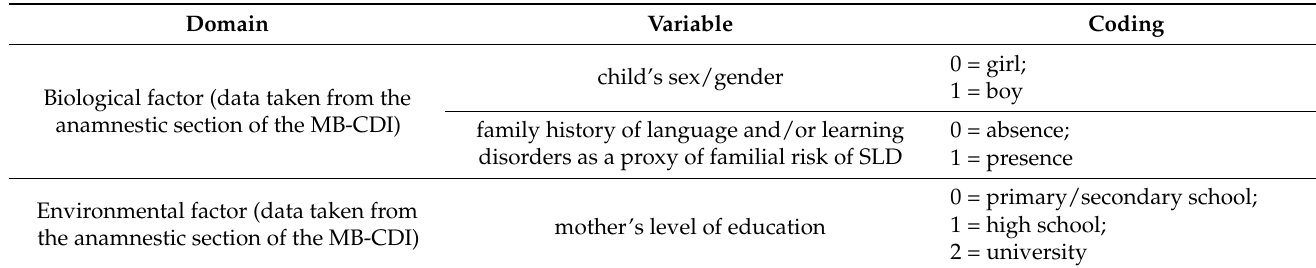
Table 1. Domains and variables coded in the first step of the